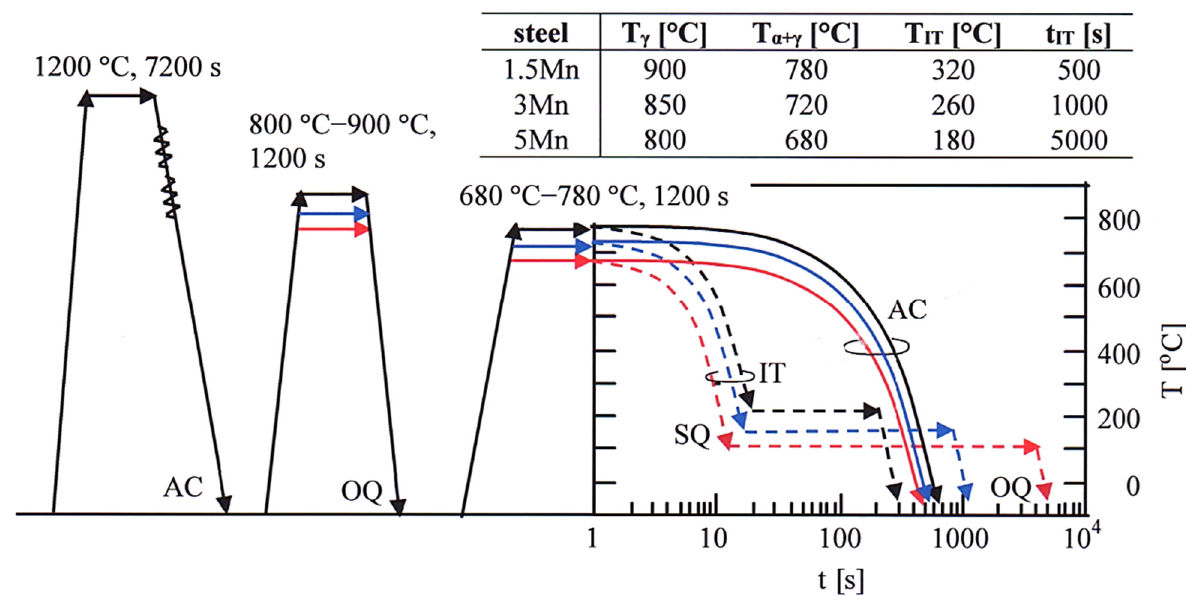
Figure 2. Heat treatment diagram of the AC and IT processes in the 1.5 Mn (black line), 3 Mn (blue line), and 5 Mn (red line) steels. OQ: quenching in an oil bath (53.5 °C/s), SQ: quenching in a salt bath (24.0 °C/s), AC: air cooling (1.2 °C/s).